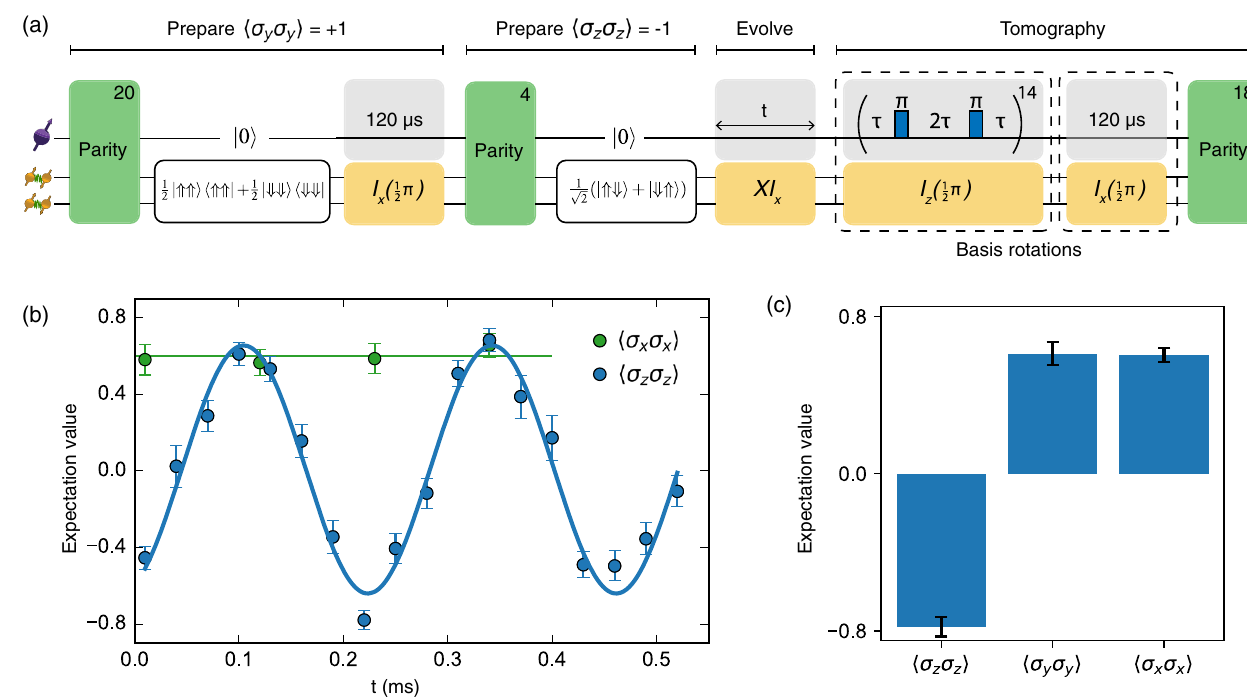
ffiffiffi p 2 Þðj ⇑⇓ i þ j ⇓⇑ iÞ by